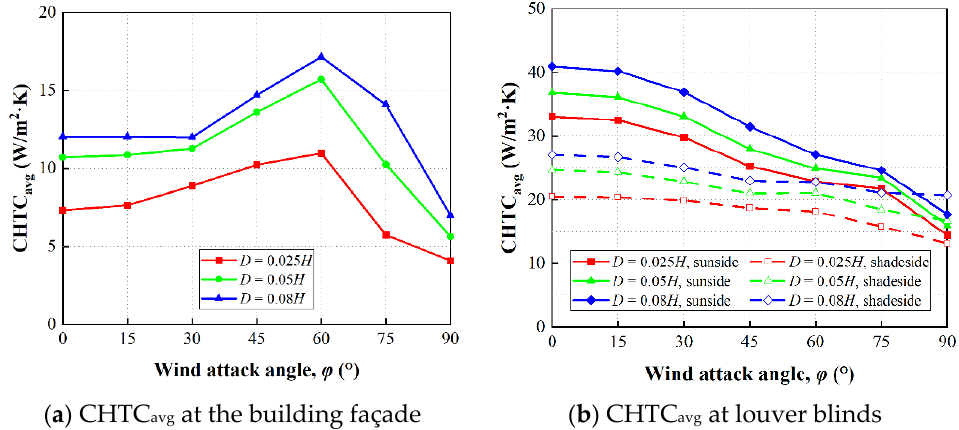
Figure 14. The flow patterns around the building façade with different louver distance D ( U ref = 3.41 m/s, B / H = 0.035, T H − T a = 10 °C, T B − T a = 20 °C, θ = 45°).